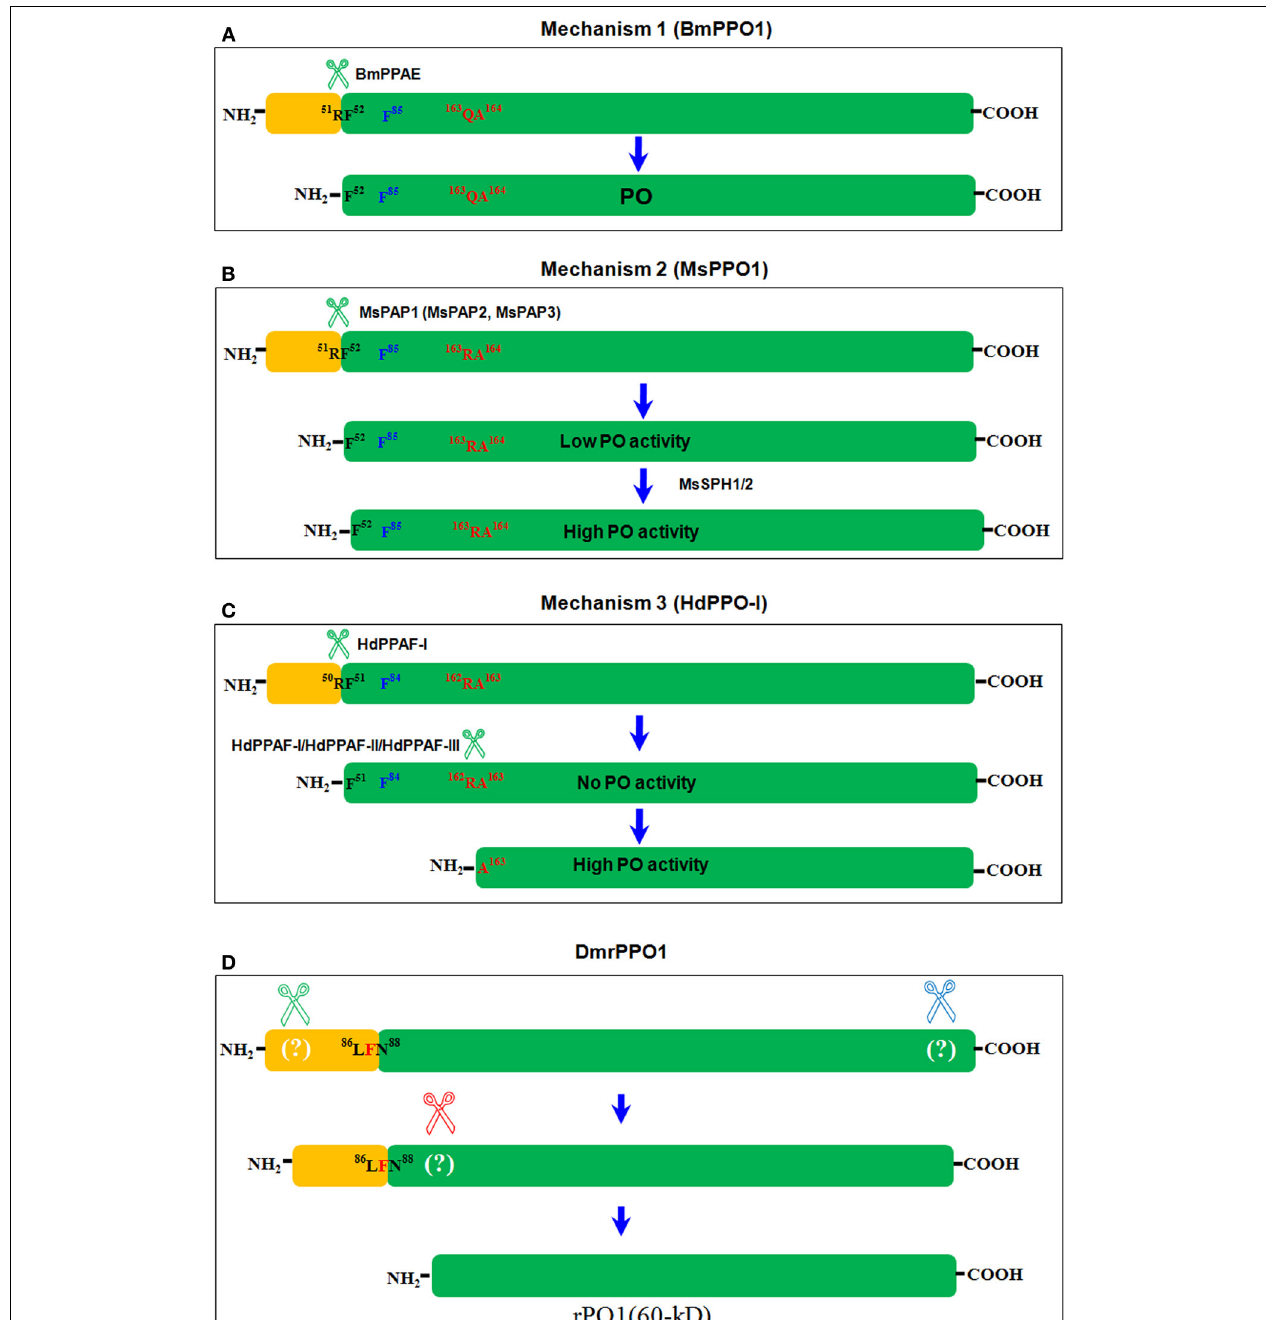
MsPPO1 (B) arealsoshown inred. In B.mori , BmPPO was cleaved by PPAEto produce PO (Ashida and Brey, 1997) (A) . In M. sexta , PAPs cleaved MsPPO in the same place as in B. mori to produce PO fragments with low enzyme activity. When SPHs were added, PO activity increased significantly